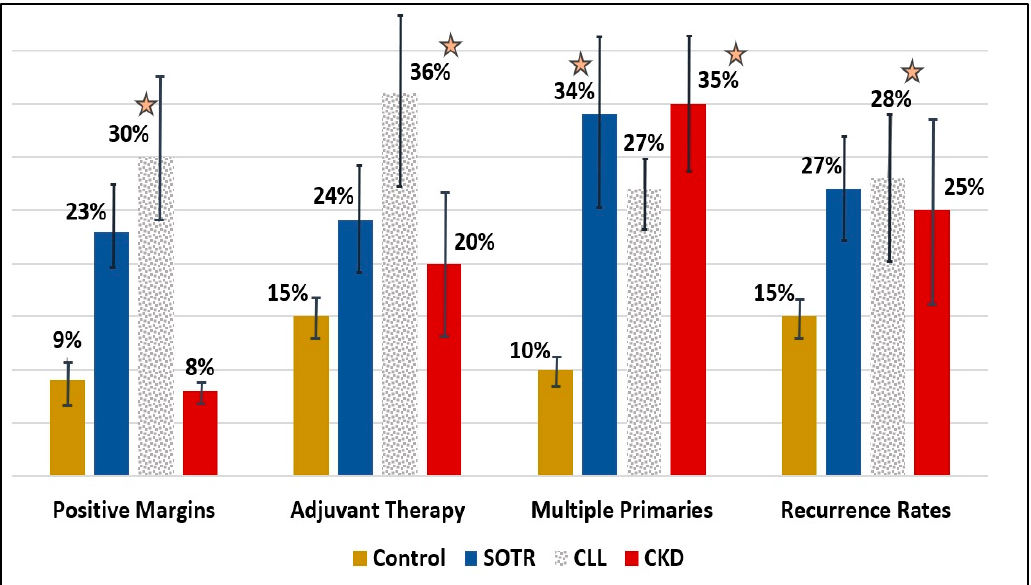
Figure 2. Bar-charts for different tumor characteristics (positive margins, adjuvant therapy, multiple primaries, and recurrence rates) for controls (black), SOTR (blue), CLL (polka dots), and CKD (red) patients. Asterisks represent a statistically significant difference ( p < 0.05) compared to controls. Error bars represent the average result ± standard deviation. SOTR; Solid Organ Transplant Recipients, CLL; Chronic Lymphocytic Leukemia, CKD; Chronic kidney disease.